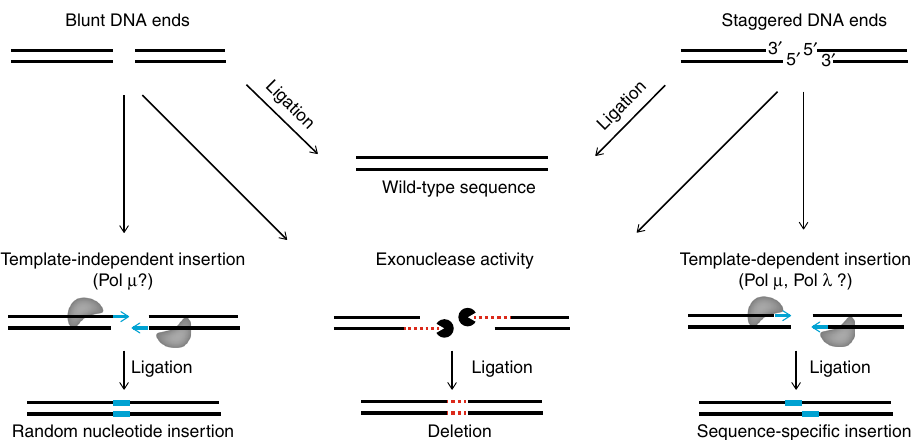
Fig. 6 Illustration of DNA repair outcomes after Cas9-induced double-strand break. Both blunt and staggered ends can be directly ligated back into wild- type sequence, or generate a deletion through resection by nuclease activity prior to ligation. Blunt ends can also result in an insertion by template- independent addition of a random nucleotide, possibly established by Pol µ . Staggered ends lead primarily to template-dependent insertions, possibly established by polymerases such as Pol µ or Pol